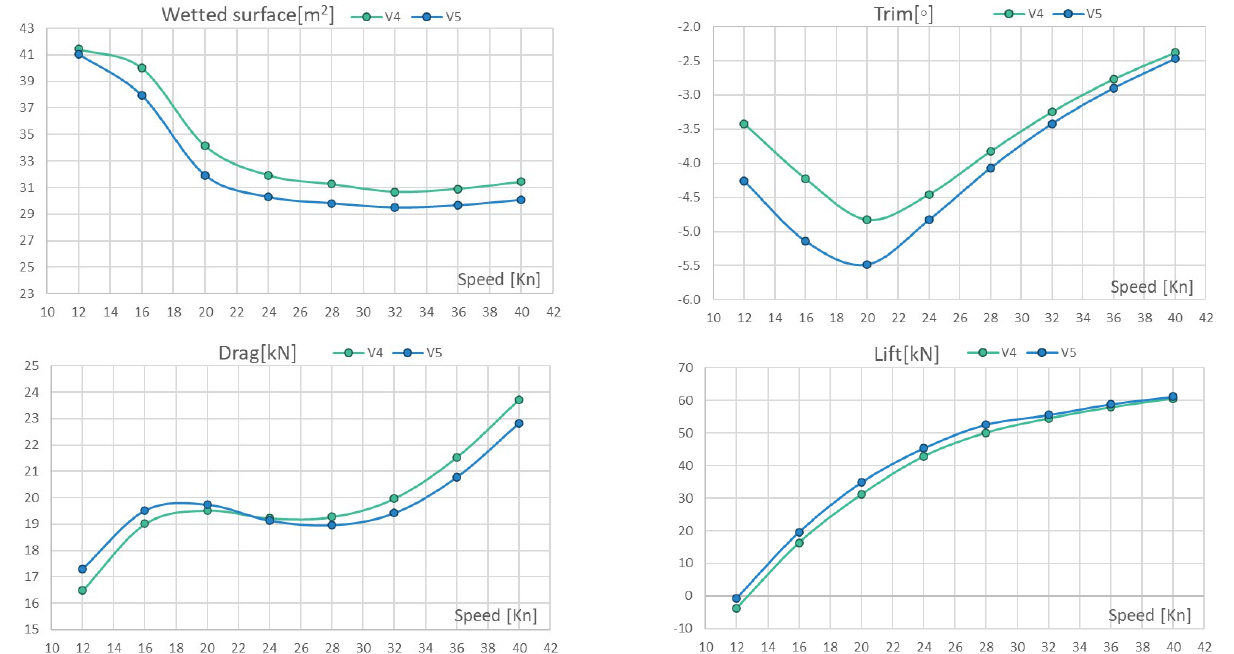
Figure 19. Variation of main computed parameters for V4 and V5. Table 19. Comparison of lift computed on SR.